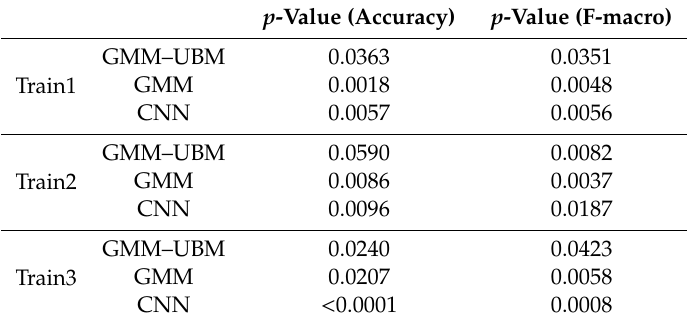
Table 9. p -value between the combined features and MFCC in violin grade